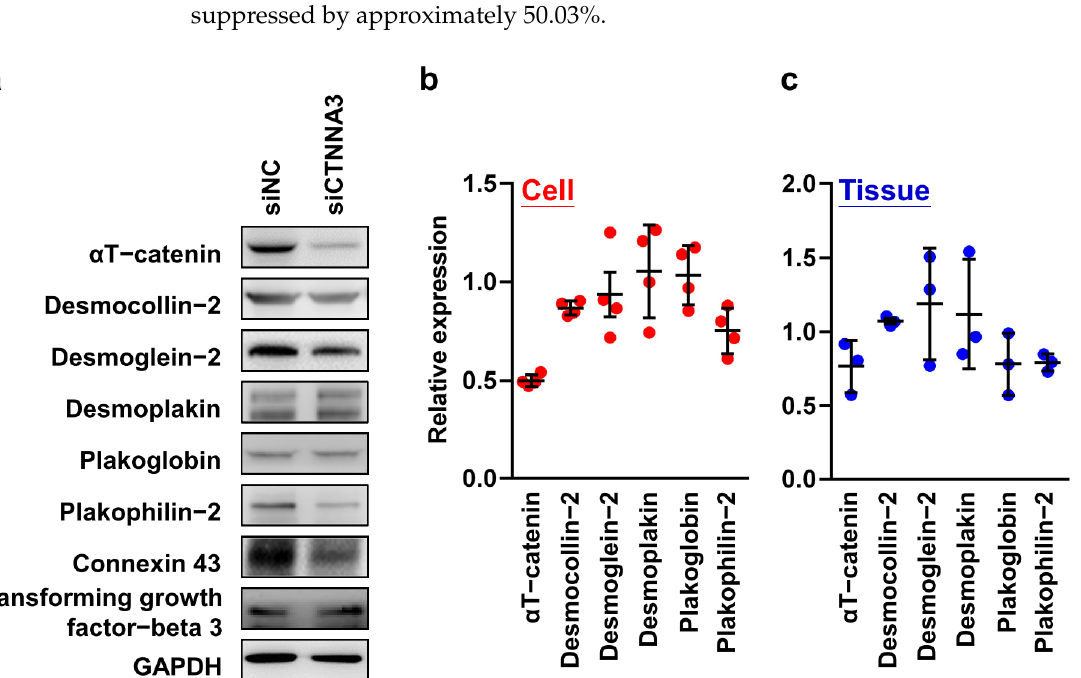
Figure 3. Analyses of protein expression in cardiomyocytes. ( a ) Protein levels in non-targeting control siRNA (siNC) and siCTNNA3 transfected HL-1 cardiomyocytes. Western blotting was performed with the indicated antibodies. Glyceraldehyde-3-phosphate dehydrogenase (GAPDH) was used as an internal control. The experiment was performed in quadruplicate. ( b ) Relative expression levels of HL-1 cardiomyocytes were calculated using the VisionWorks 8.20 software. The expression level was calibrated using GAPDH (internal control). ( c ) The immunoreactive intensity of IHC staining in patients with CTNNA3 mutations was analyzed using ImageJ. The relative intensity was calibrated in the control group.